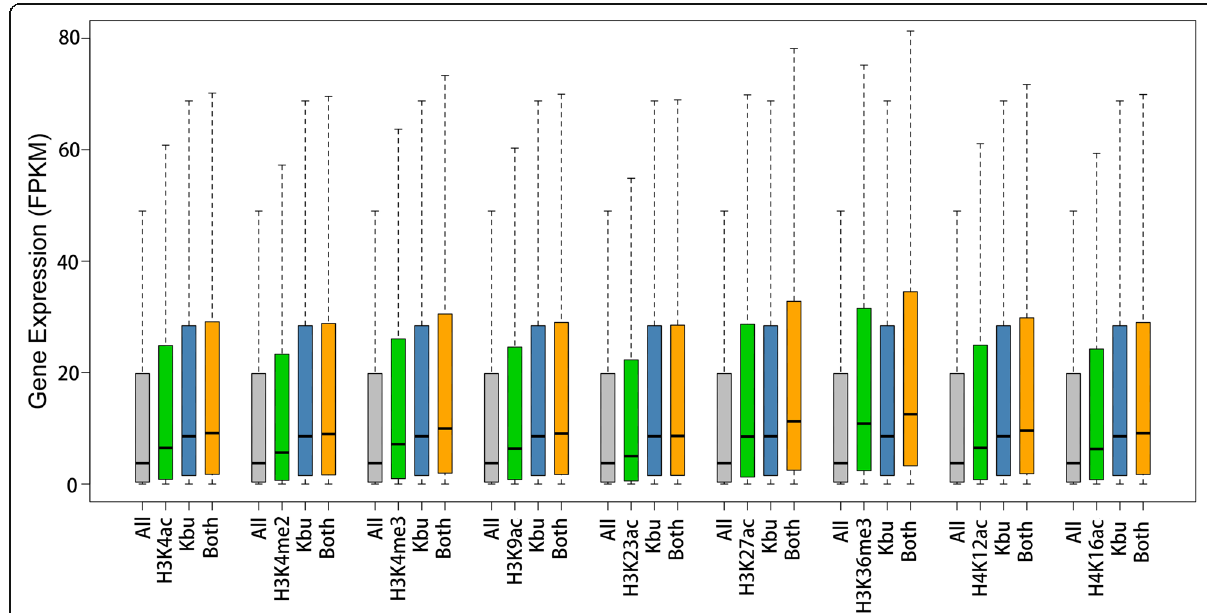
Fig. 6 Comparisons of the expression of genes associated with different combinations of histone modifications. The non-TE gene expression values (FPKM: Fragments per Kilobase Million) of each combination are indicated by box plots. All: all rice genes. Kbu: all genes with Kbu modifications. Both: genes with both Kbu and one of the other nine modifications as shown. The asterisks (*) indicate a significant difference between the pairwise combinations ( p < 2.2e-16, Kolmogorov-Smirnov